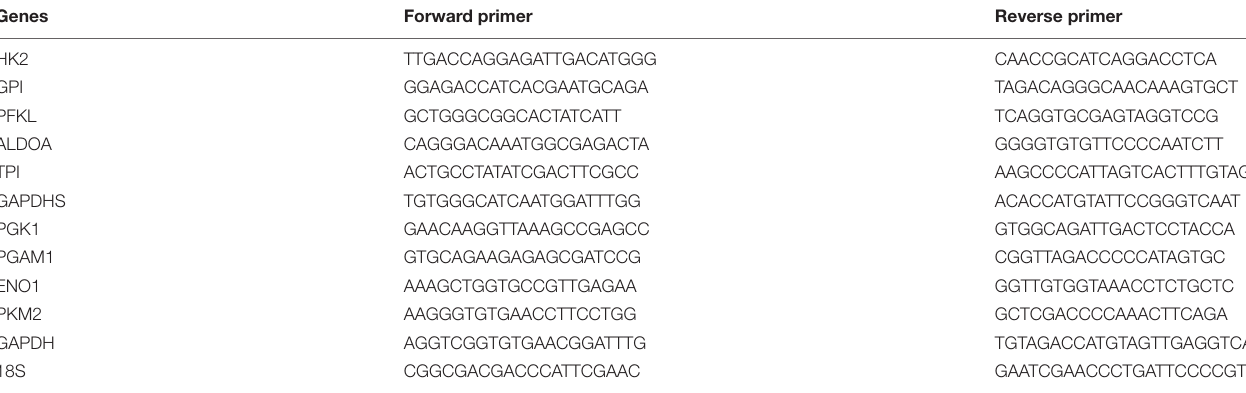
TABLE 1 | The sequence of primers used in our study.